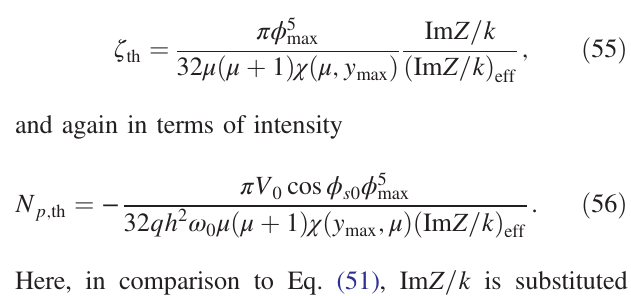
FIG. 7. The LLD intensity threshold in the logarithmic scale τ as a function of f calculated with MELODY (squares) and r full Eq. (50) (lines) for two different values of zero-intensity bunch length and a broadband resonant impedance with Im Z=k ¼ 0 . 07 Ω and Q ¼ 1 ; η > 0 , V 6 MV and μ ¼ 2 . The corre- 0 ¼ sponding intensity parameter ζ is shown on the second vertical